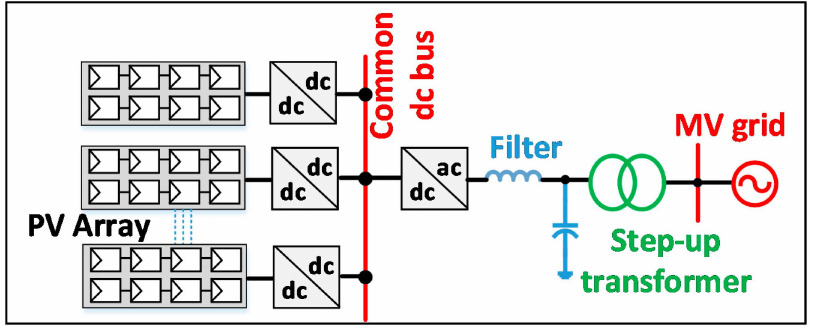
Figure 1. Traditional large-scale PV plant